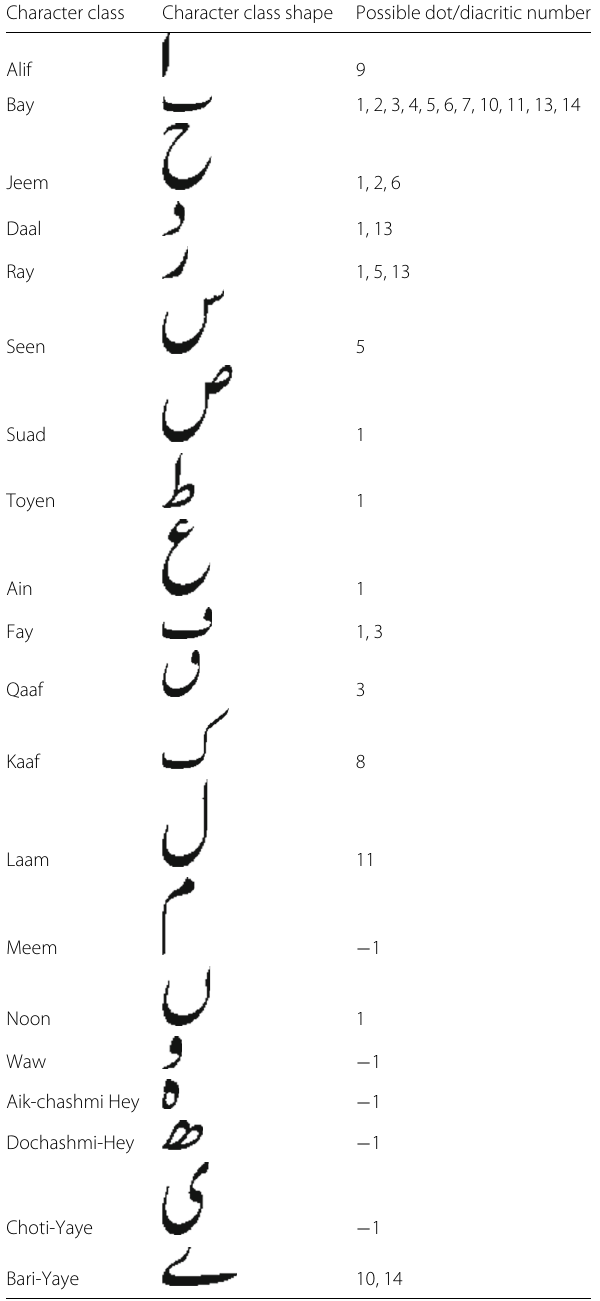
Table 6 Lookup table for character classes—possible occurrences of dots/diacritics